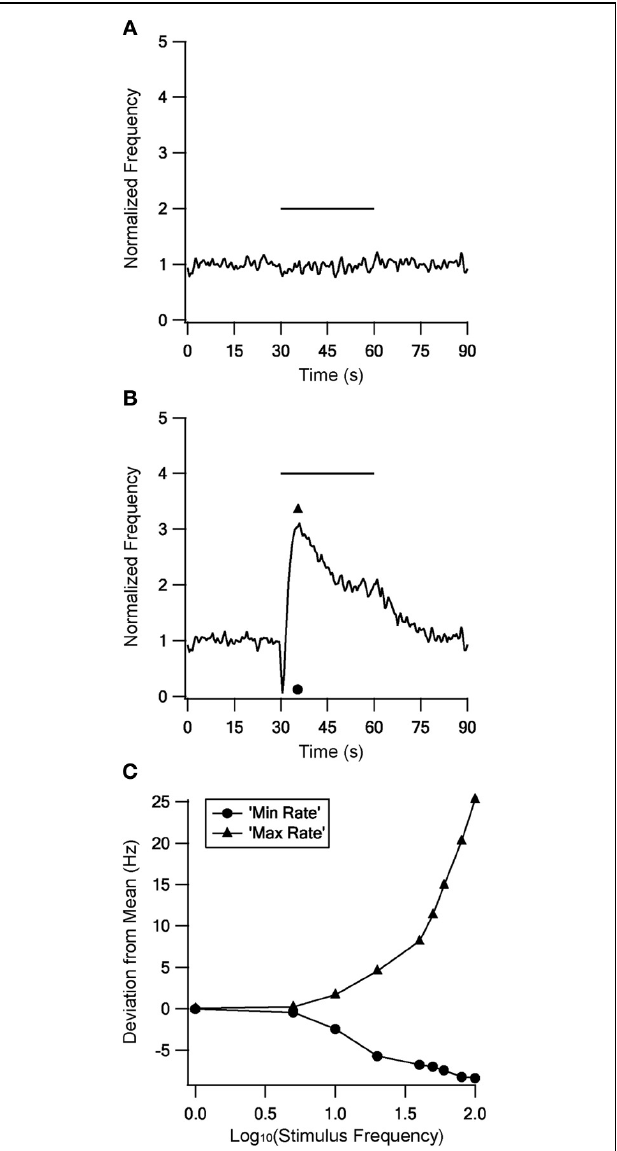
FIGURE 8 | The model response to stimulation at different frequencies. The model response to stimulation at 5Hz (A) and 100Hz (B) to illustrate the responses to LFS and HFS respectively. (C) Minimal (circles) and maximal (triangles) firing rates observed during each stimulus